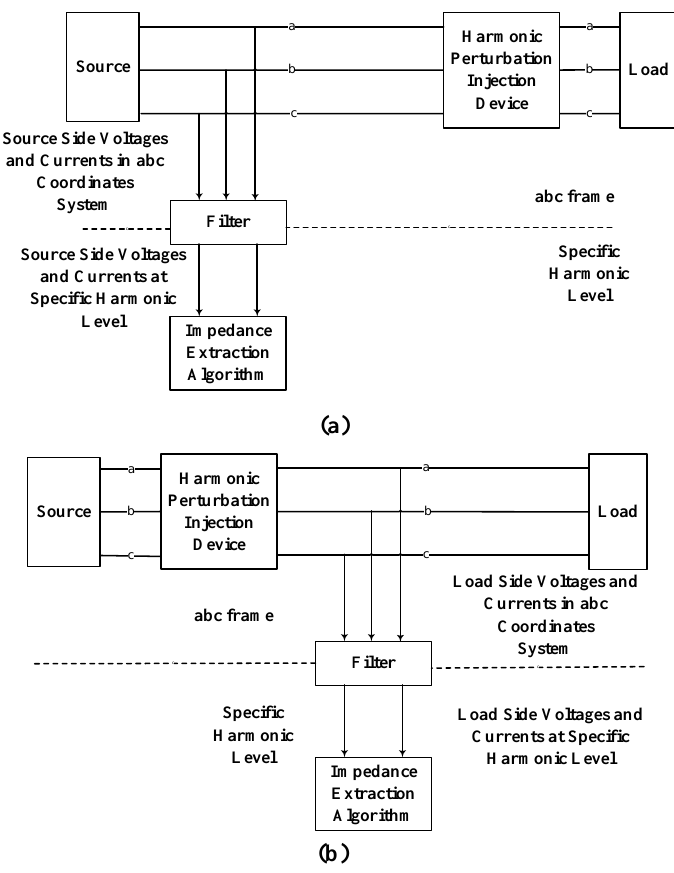
Figure 7. Impedance measurement setup for the ( a ) source side and ( b ) load